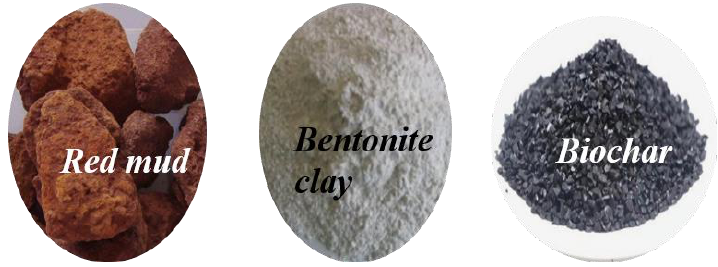
Figure 5. The types of low-cost